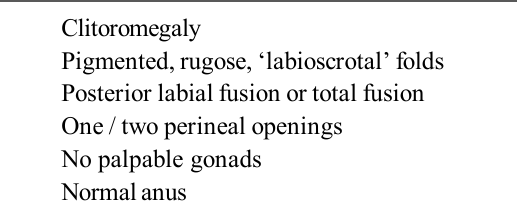
Table 1. Appearance of the external genitalia in